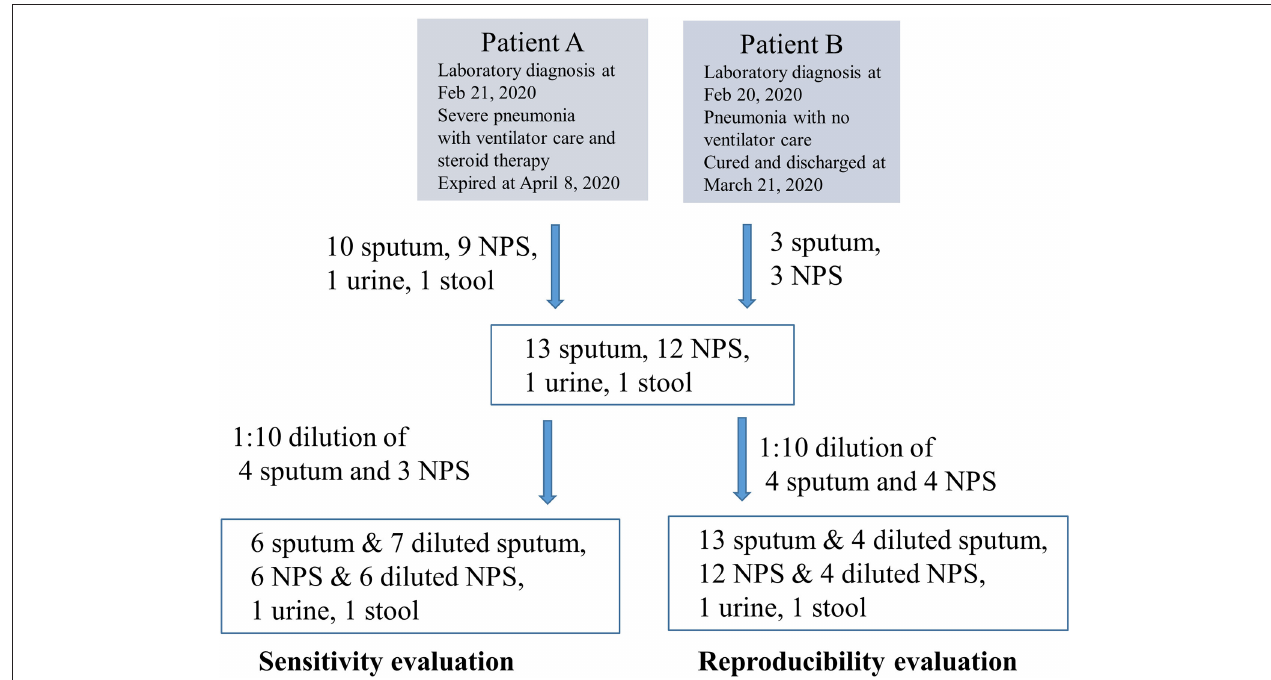
FIGURE 1 | Summary of the clinical specimens for evaluating sensitivity and